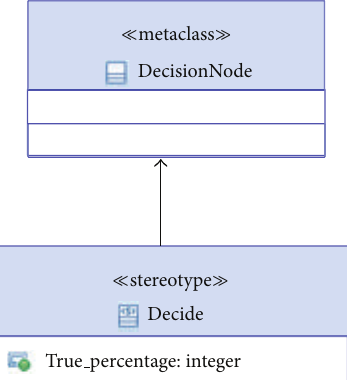
Figure 10: The metaclass DecisionNode and its stereotype.